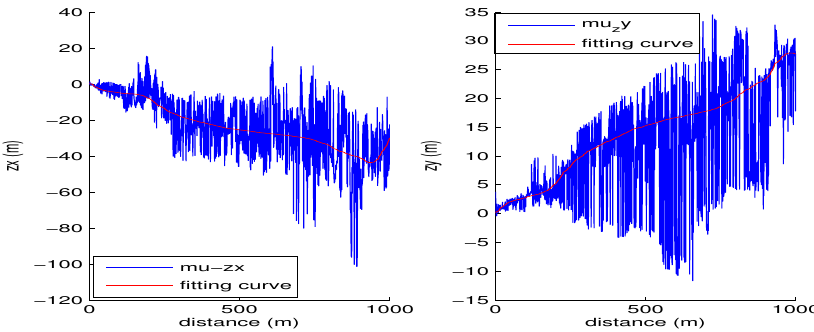
Figure 15. The regression result of system noise and working distance in the process of AUV docking with mobile DS.